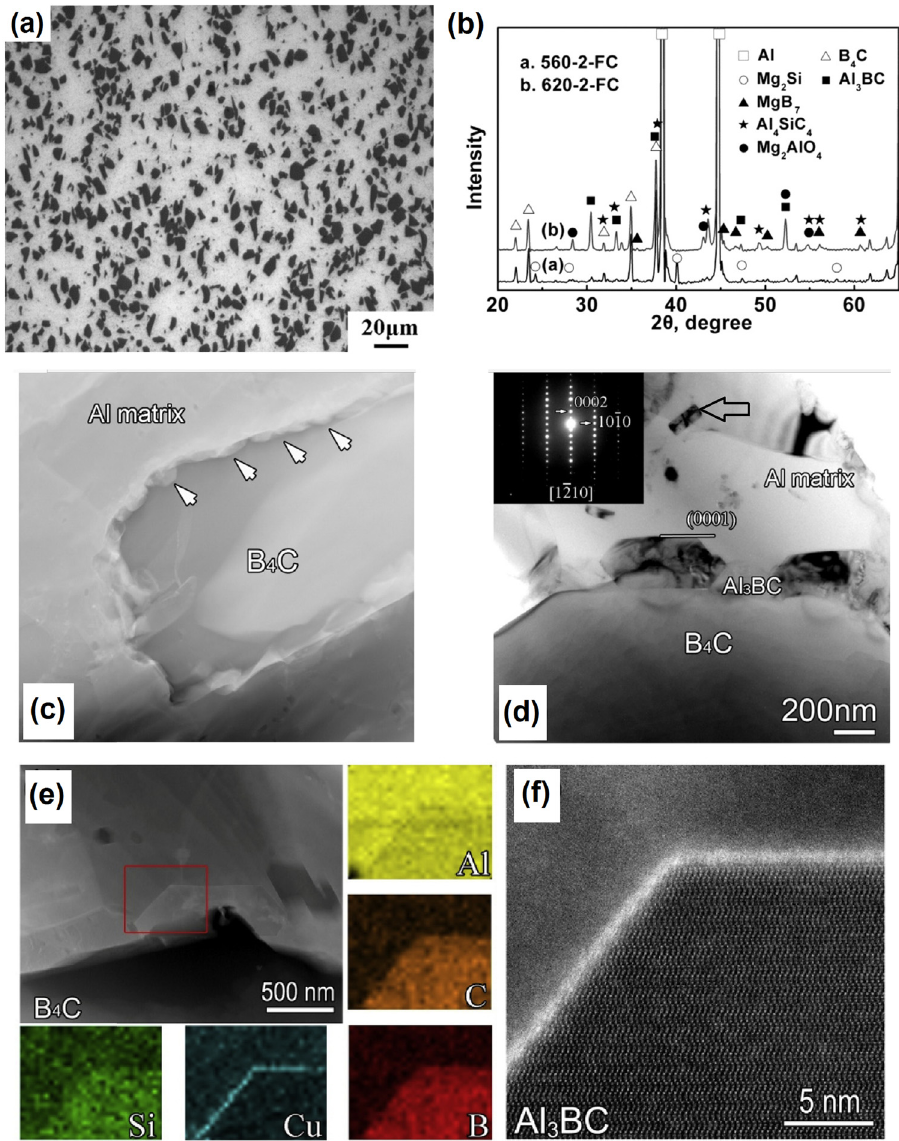
Figure 8: ( a ) OM image of an Al – 1.0 Mg – 0.65 Si – 0.25 Cu ( wt% ) alloy reinforced with 20 wt% of B 4 C. ( Reproduced with permission from [ 150 ] . ) ( b ) XRD di ff ractograms of this composite under di ff erent processing variables. ( Reproduced with permission from [ 150 ] . ) ( c ) HAADF - STEM image of the B 4 C reinforcement surrounded by reaction products. ( d ) TEM image of the Al 3 BC nanoparticles at the interface Al/B 4 C ( SAED pattern inserted ) . ( e ) HAADF - STEM image for the analysis of the Al - 3 BC/matrix interface. EDS mappings show the elements distri bution. ( f ) High - resolution HAADF image of the Al 3 BC particle, surrounded by a 0.7 nm Cu layer (( c ) – ( f ) Reproduced with permission from [ 152 ] . )